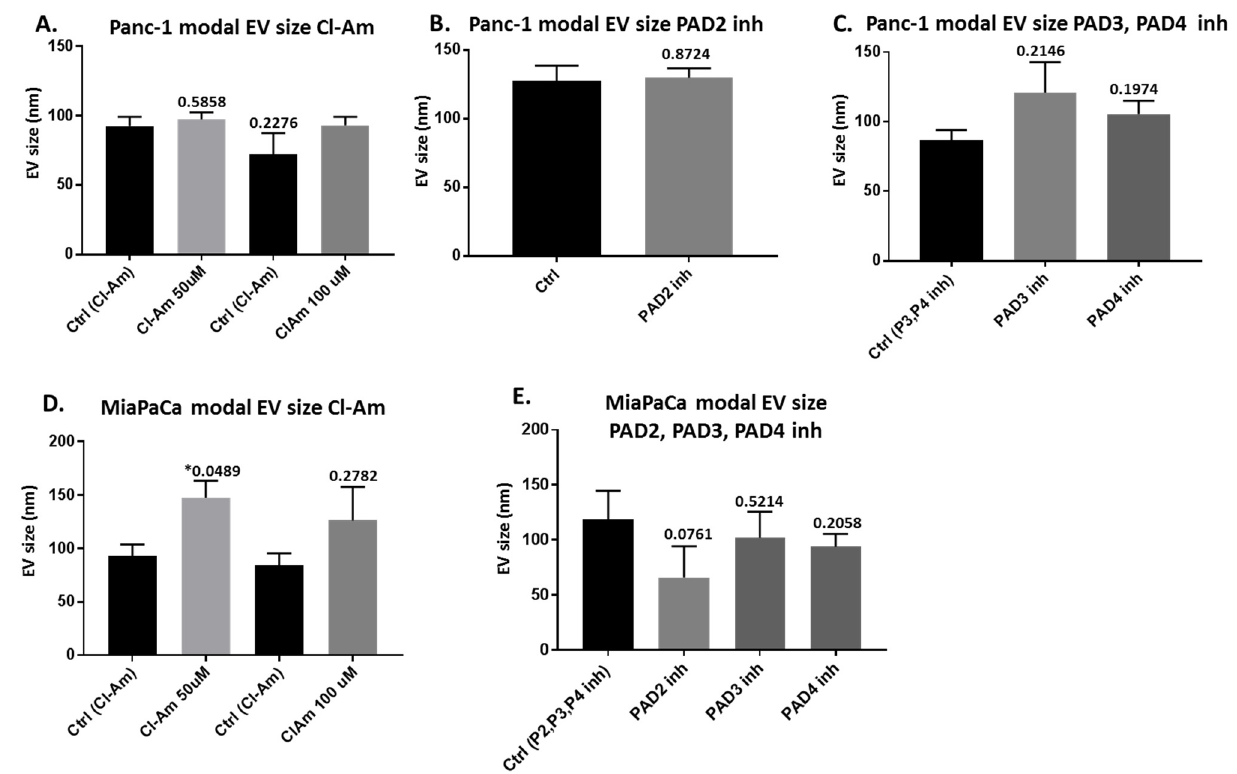
Figure 5. Modal EV size profiles from PDAC cells following 1 h treatment with pan-PAD and PAD isozyme-specific inhibitors. ( A ) Modal size of EVs released from Panc-1 cells following Cl-amidine treatment (50 and 100 µ m respectively), compared with control (PBS)-treated cells ( B ) Modal size of EVs released from Panc-1 cells following PAD2 inhibitor treatment, compared with control (DMSO)-treated cells. ( C ) Modal size of EVs released from Panc-1 cells following PAD3 and PAD4 inhibitor treatment, compared with control (DMSO)-treated cells. ( D ) Modal size of EVs released from MiaPaCa-2 cells following Cl-amidine treatment (50 and 100 μ m, respectively), compared with control (PBS)-treated cells. ( E ) Modal size of EVs released from MiaPaCa-2 cells following PAD2, PAD3, and PAD4 inhibitor treatment, compared with control (DMSO)-treated cells. The histograms show treatments run together, respectively. Exact p -values are indicated ( * highlights significance at p ≤ 0.05), error bars show SD ( n = 3 biological replicates for all).